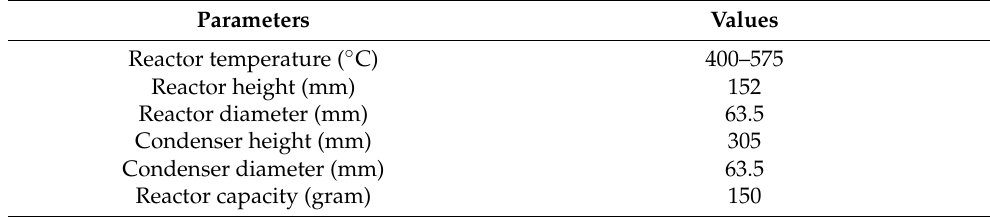
Table 2. Slow pyrolysis reactor configurations.